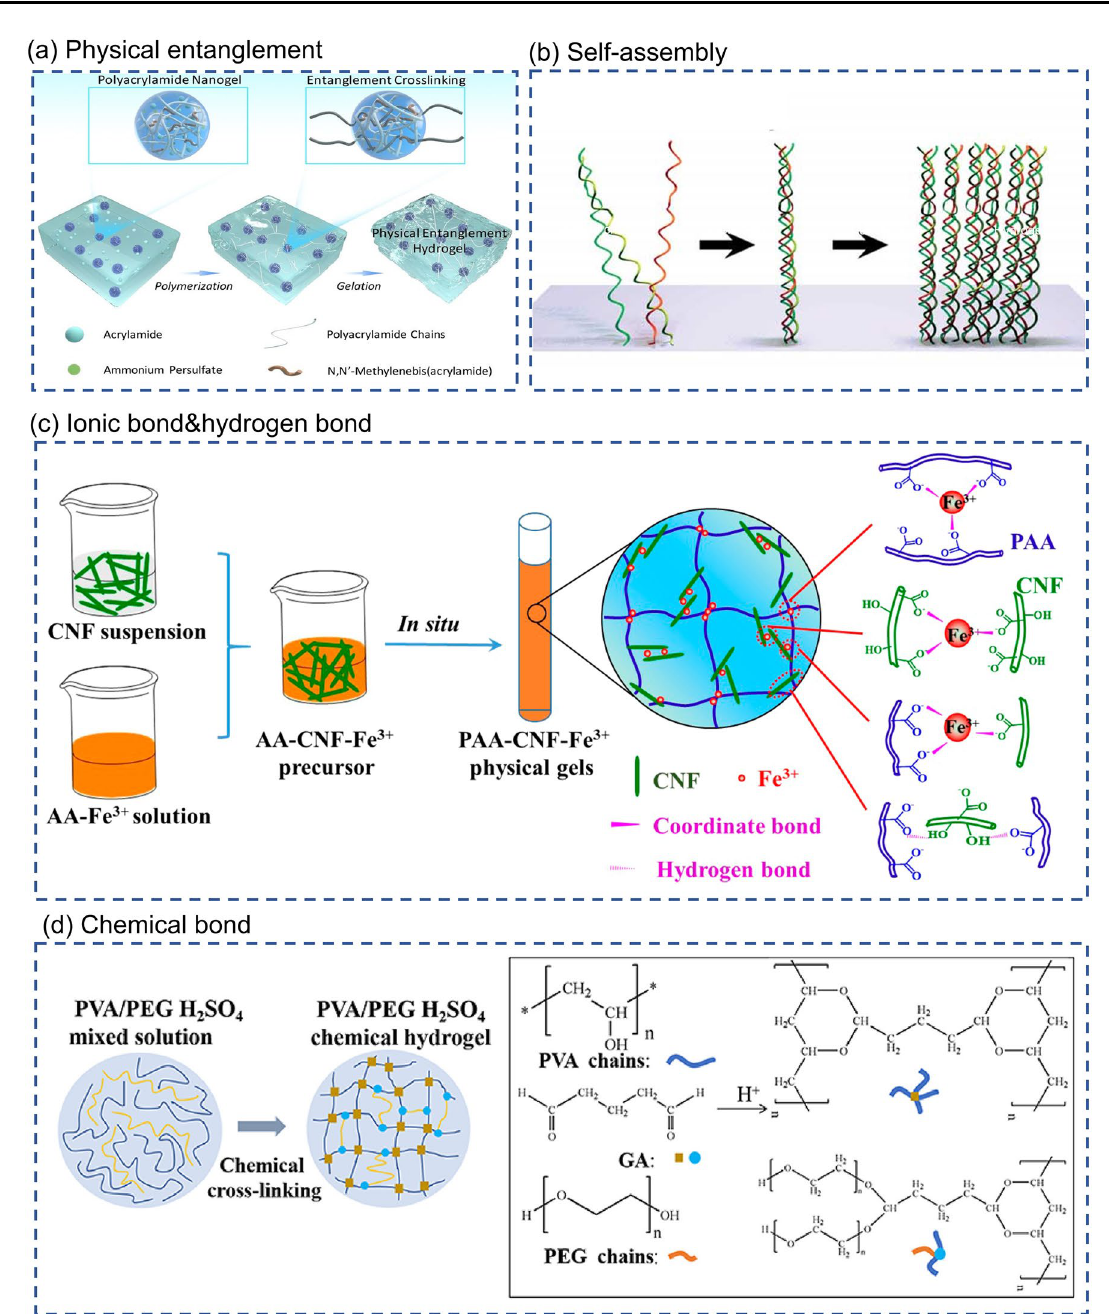
Fig. 2 Synthesis mechanisms of hydrogel. a Physical entanglement. Schematical illustration of the formation of physical entanglement hydro- gels (PEH). Polyacrylamide nanogels absorbed acrylamide monomer and initiator which undergo in situ polymerization to form “entanglement cluster” to gel the system [65]. Reproduced with permission. Copyright 2010, Royal Society of Chemistry. b Self-assembly [21]. Reproduced with permission. Copyright 2017, American Chemical Society. c Ionic bond and hydrogen bond. Schematic of one-pot preparation of PAA- CNF-Fe 3+ physical gels and illustrations of hydrogen bonds and dual coordinate bonds [66]. Reproduced with permission. Copyright 2017, American Chemical Society. d Chemical bond. The chemical cross-linking process of PVA/PEG H 2 SO 4 chemical hydrogel [70]. Reproduced with permission. Copyright 2020,